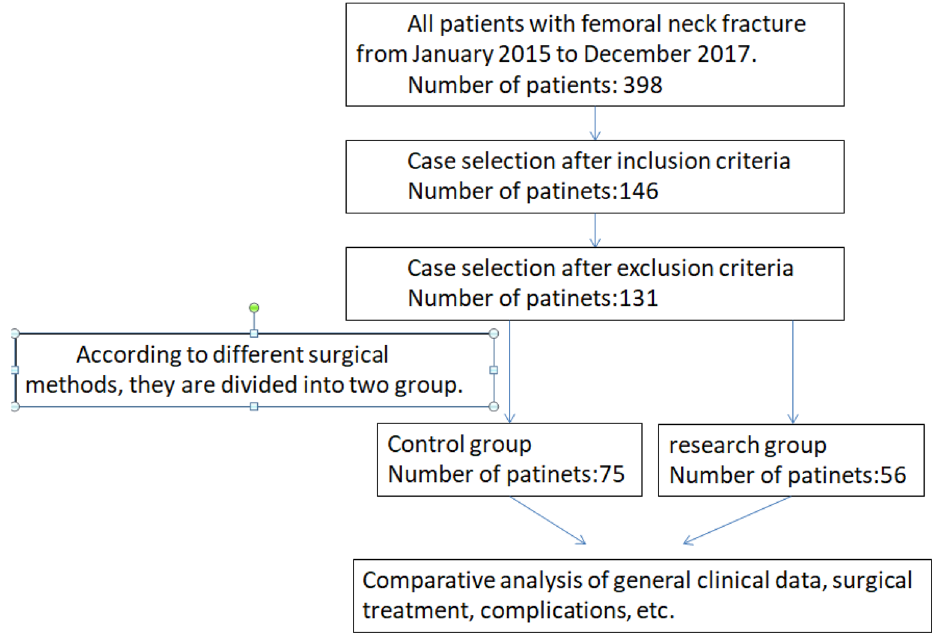
Figure 9. Clinical research flow chart.